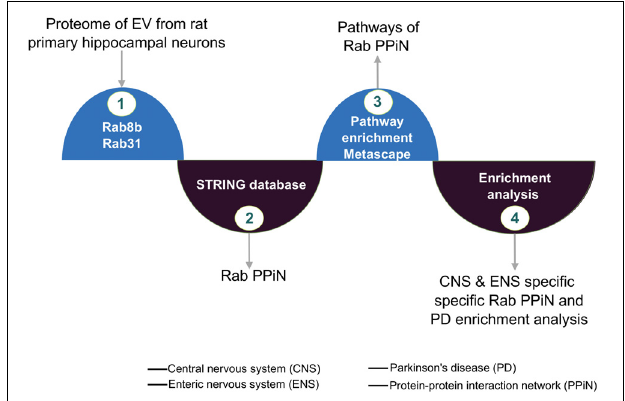
FIGURE 1 | FGF2-mediated Rab protein enrichment and interactions. Graphic illustrating Rab8b and Rab31 protein’s network and the integrated analysis from extracellular vesicle (EV)